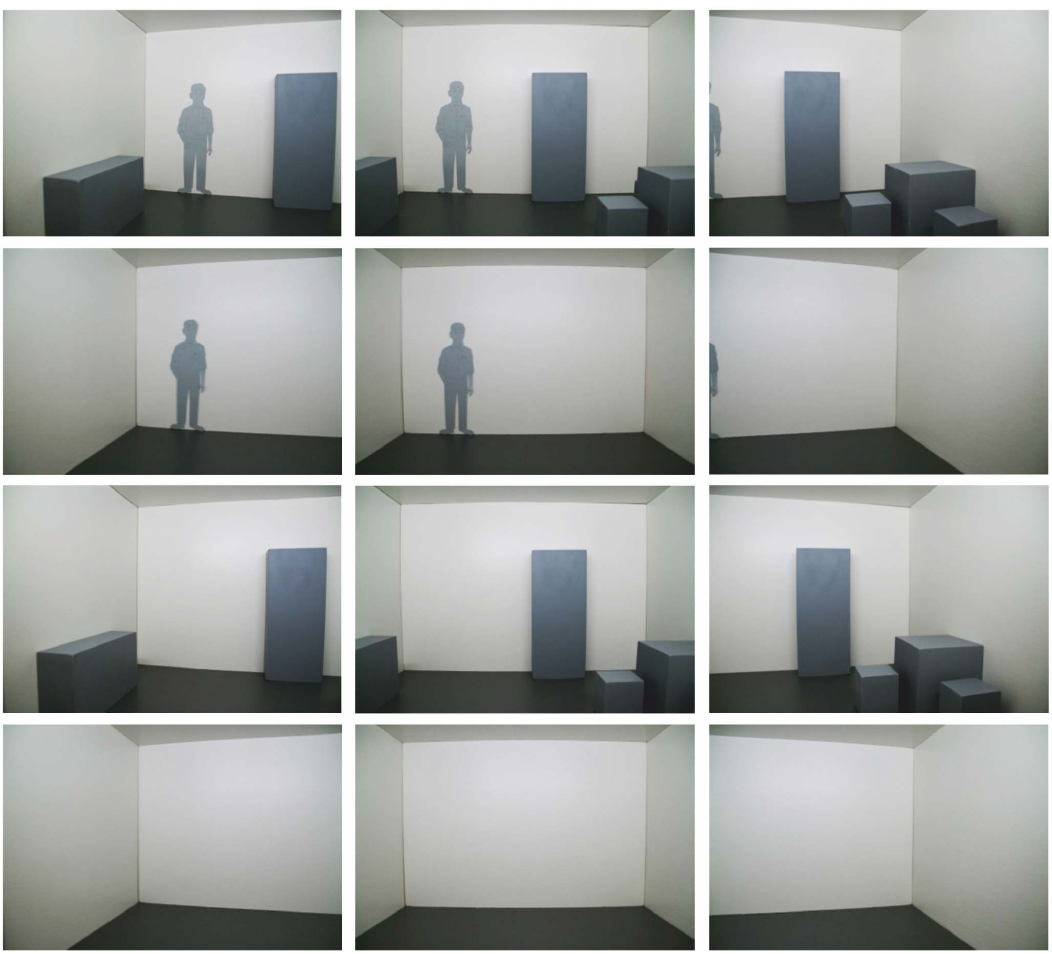
Figure 3. Experiment 1: Interior view in the maximum left, default, and maximum right viewing direction of the furnished (first row) and the unfurnished (second row) model room with the additional scaling cue as well as of the furnished (third row) and the unfurnished (fourth row) model room without the additional scaling cue.